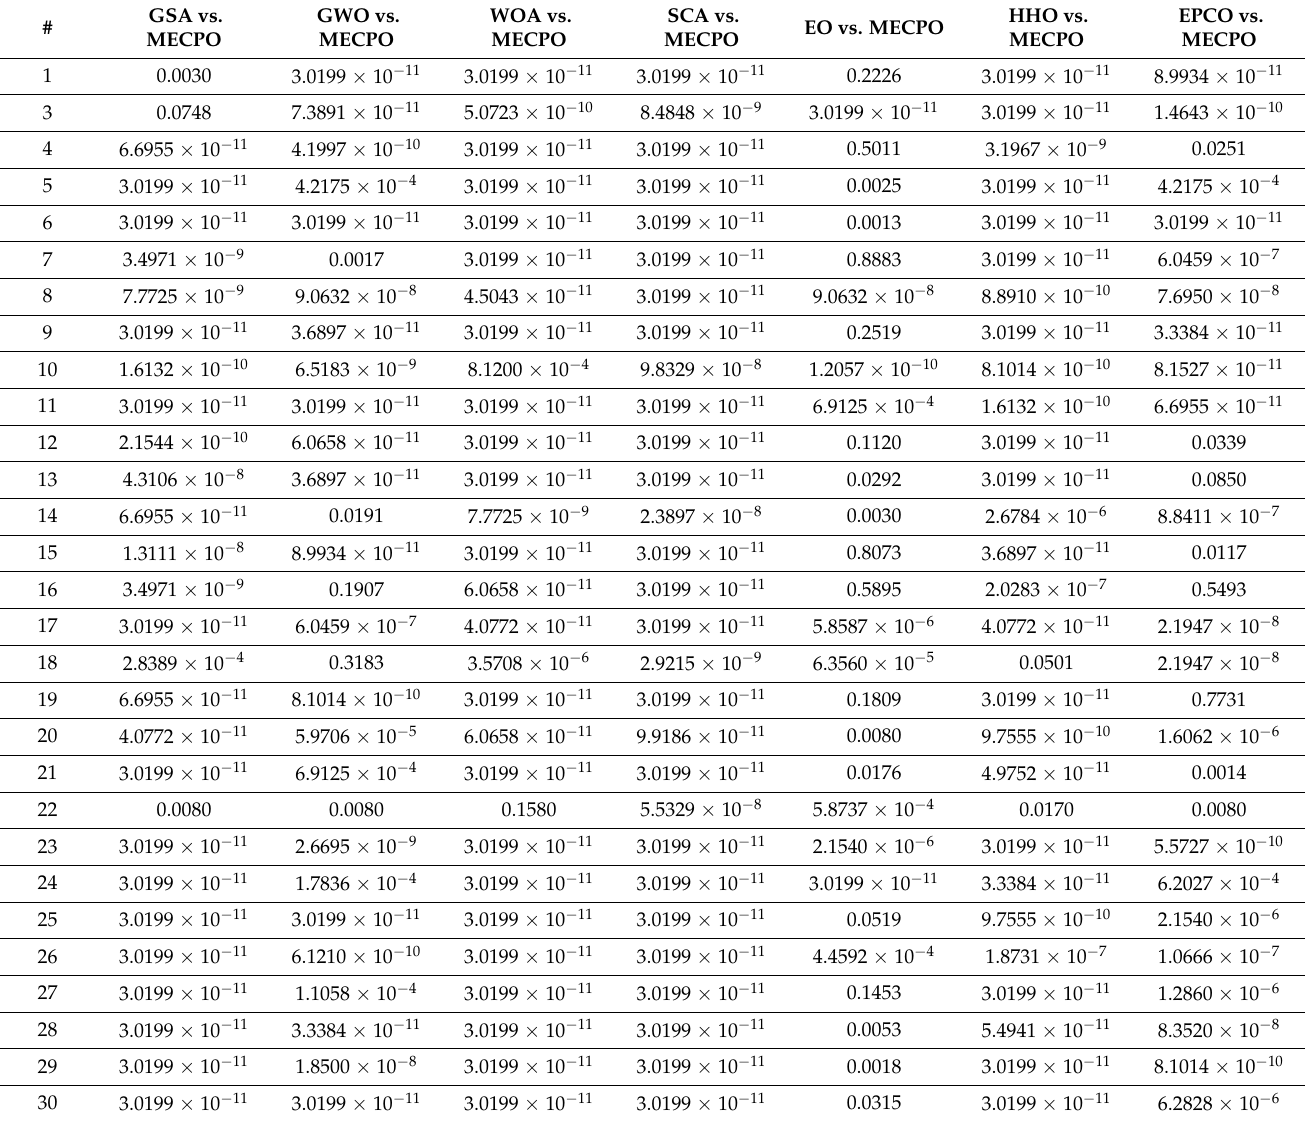
Table 4. Results of Wilcoxon’s test ( p ≥ 0.05) between the MECPO technique and the various recent techniques for the CEC’17 functions with Dim =